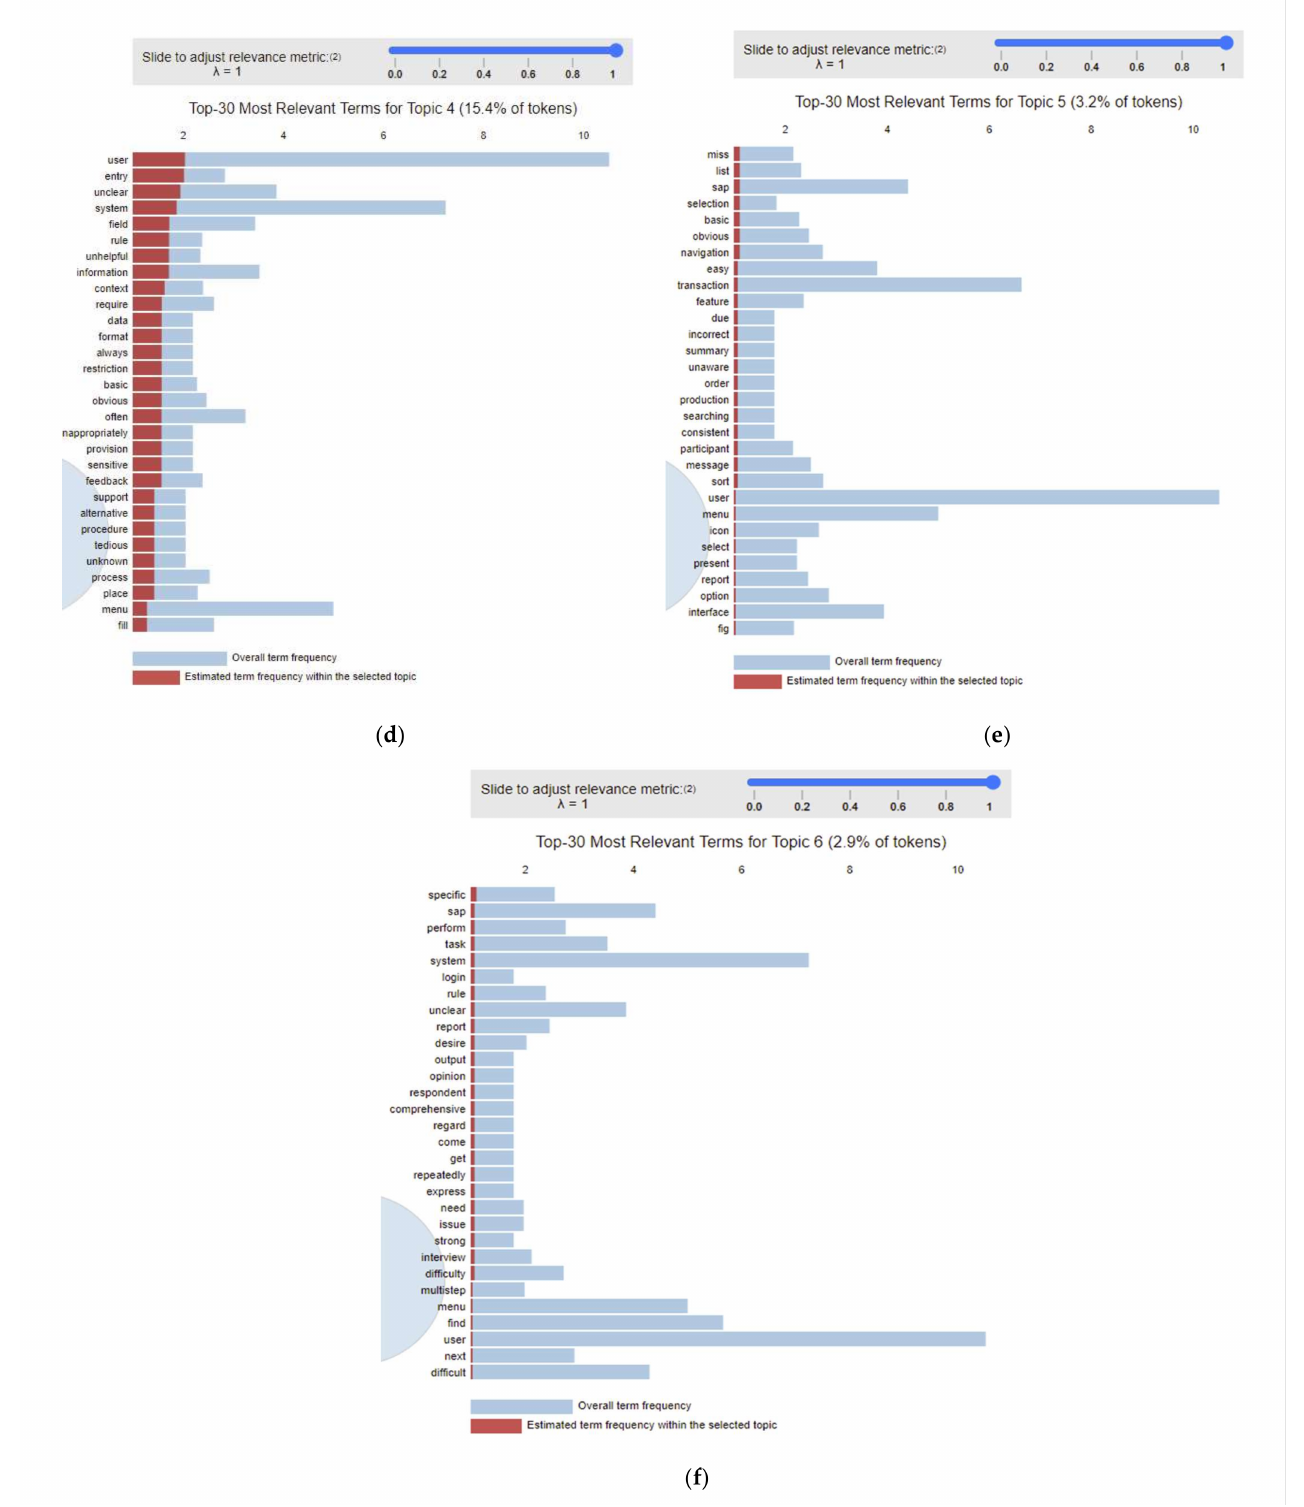
Figure 3. LDAvis presentation of LDA topic modeling of the ERP systems usability issues in ( a ) Topic 1, ( b ) Topic 2, ( c ) Topic 3, ( d ) Topic 4, ( e ) Topic 5 and ( f ) Topic